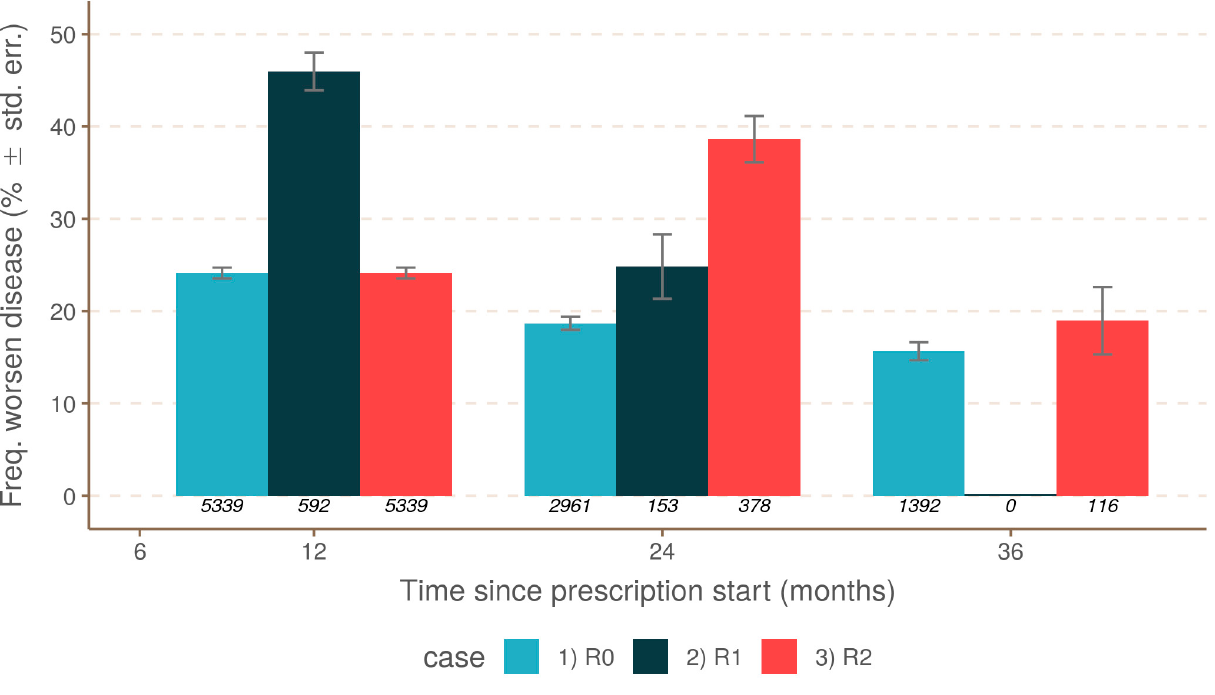
Figure 4. Comparison between MRI activity and the three scenarios: R0 (no relapse), R1 (relapse during the first year), and R2 (relapse during the second year).